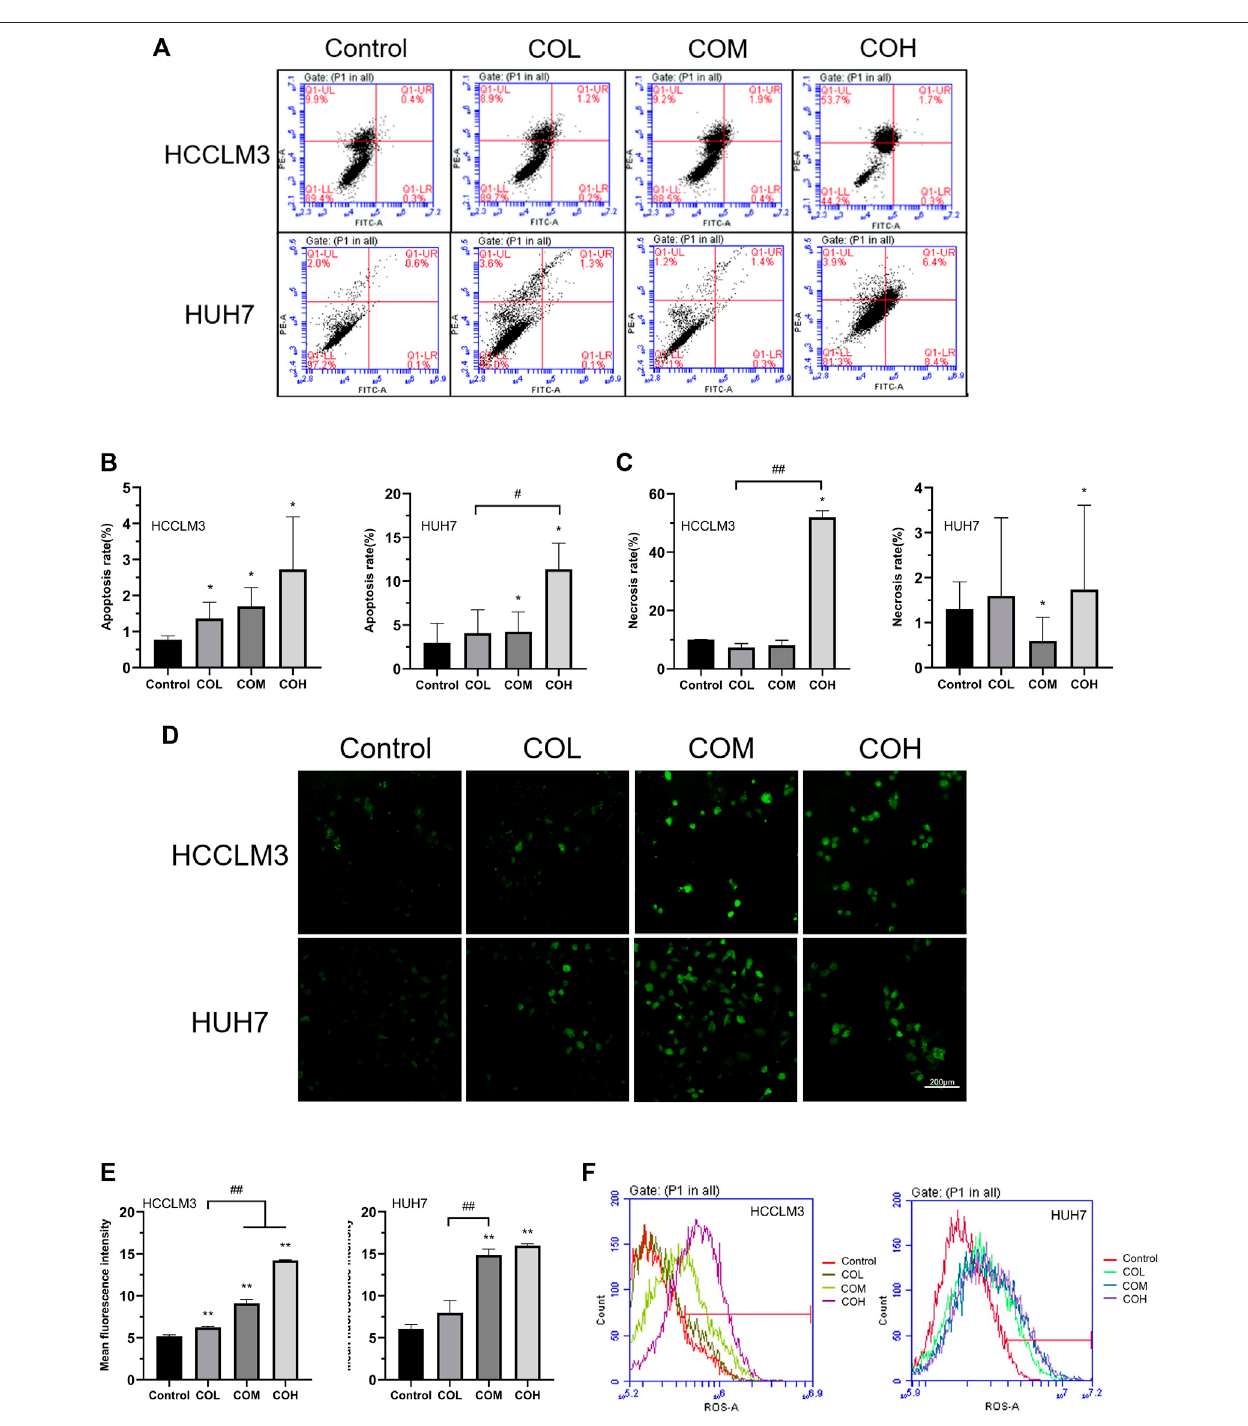
FIGURE 2 | Effects of caryophyllene oxide on apoptosis and reactive oxygen species in HCCLM3 and HUH7 cells. (A) Flow cytometry was used to detect the Annexin V-FITC/PI of HCCLM3 and HUH7 cells, and the results were expressed as apoptosis rate and necrosis rate. (B) , (C) , (D) , and (E) Laser confocal microscopy revealed the formation ofROS in HCCLM3 and HUH7 cells (200). (F) Flow cytometry was used todetect ROS in HCCLM3 and HUH7 cells. The data were presented as mean ± SD. * p < 0.05, ** p < 0.01 when compared to the control group. # p < 0.05, ## p < 0.01 when compared to the COL group.